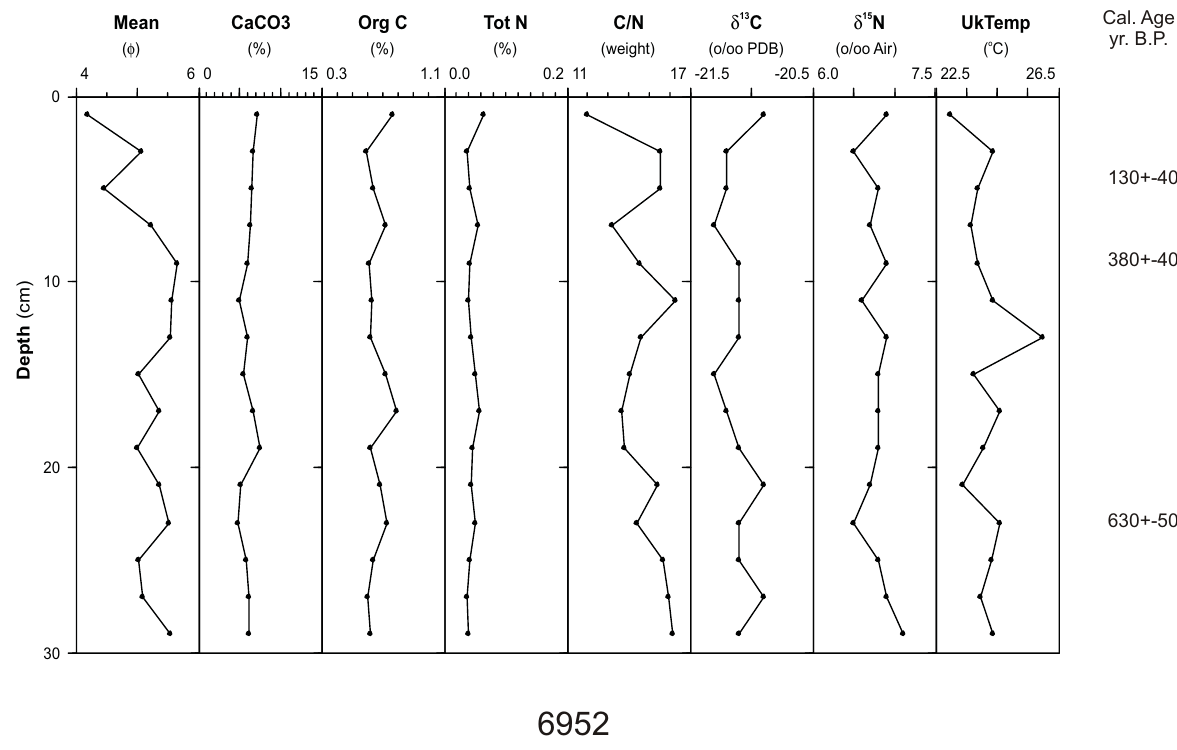
Fig. 5 – Mean grain-size, compositional, isotopic, and paleotemperature variations along core